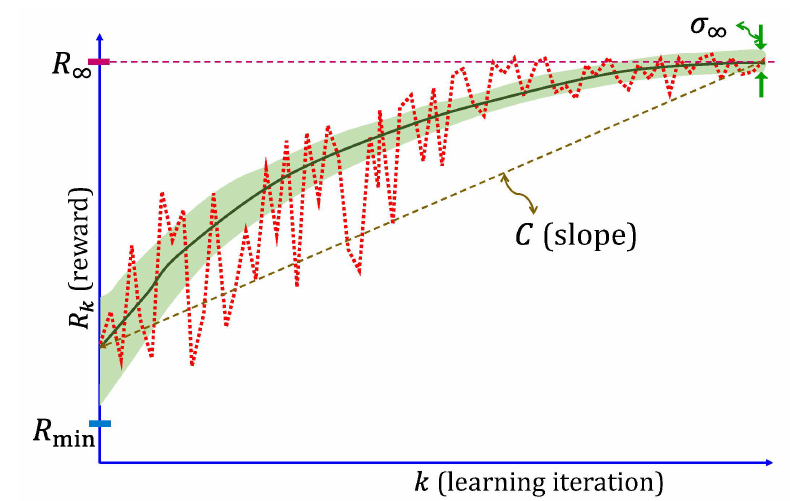
Figure 17. Proposed Performance Metrics. The four metrics across multiple runs for performance evaluation of an RL algorithm that have been suggested by the authors for HEMS and other practical applications. A typical trajectory obtained from a single run (dashed red), the average of multiple runs (solid green), and the variance (shaded light green) are shown. The quantity R min is the minimum attained from all